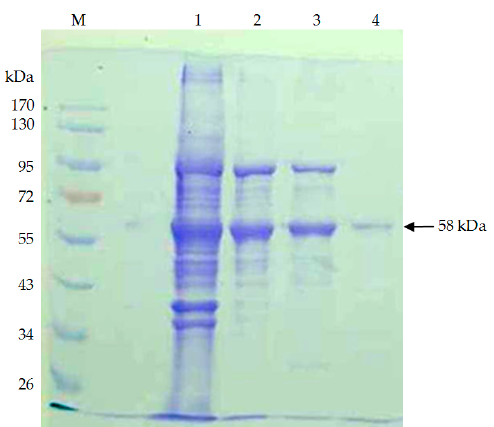
Figure 3. Sodium dodecyl sulphate polyacrylamide gel electrophoresis (SDS–PAGE) analysis of PLA depolymerase produced by P. tamsuii TKU015. Lanes: M, molecular markers (170, 130, 95, 72, 55, 43, 34, and 26 kDa); (1) crude enzyme; (2) adsorbed PLA depolymerase fractions after DEAE-Sepharose CL-6B chromatography; (3) adsorbed PLA depolymerase fractions after Macro-prep DEAE chromatography;